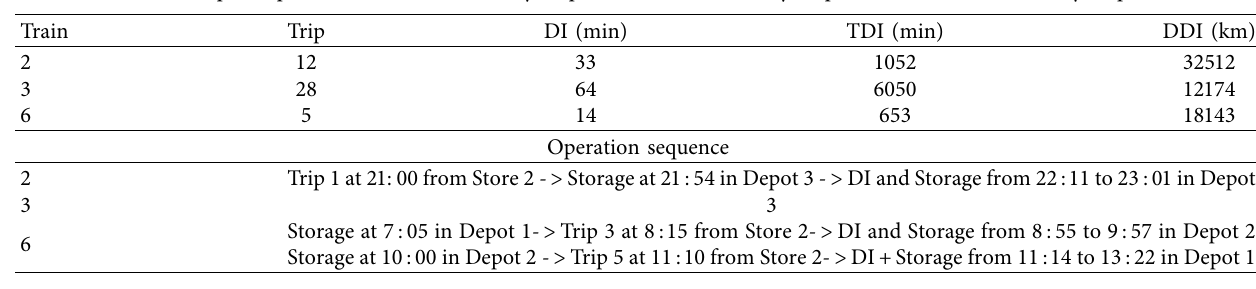
Figure 10: Maintenance scheduling of EMU. Table 3: Example of performance tests (DI: daily inspection; TDI: total daily inspection; DDI: distance daily